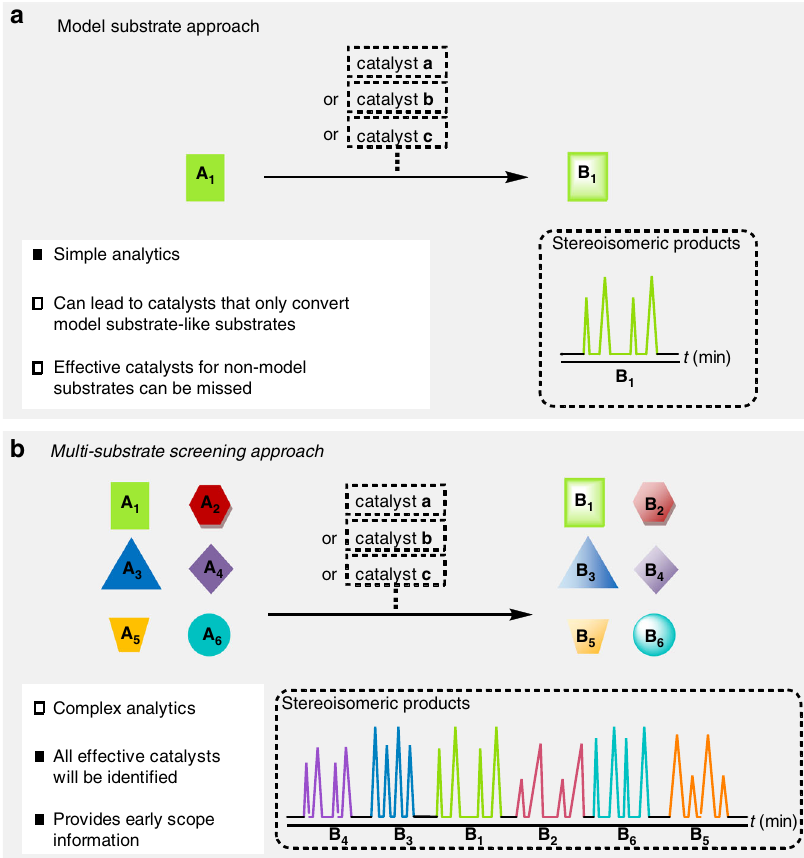
Fig. 1 Two approaches to identify a selective catalyst. a Model substrate approach vs. b multi-substrate screening